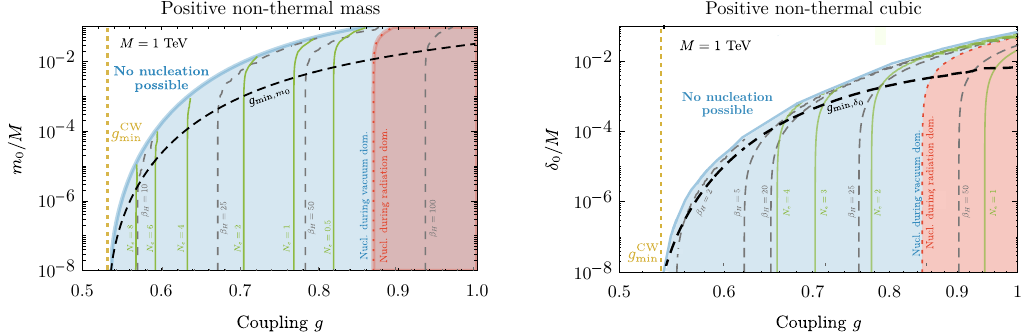
Figure 6 . Shrinking the supercooling window as a result of explicit conformal symmetry breaking with a positive mass-squared (left) and a positive cubic (right) , for a fixed scale of M = 1 TeV . Light blue shaded regions indicate a supercooled PT, while the light red regions indicate nucleation during radiation domination. The white region does not exhibit bubble nucleation, while the transparent blue line indicates the boundary of the supercooling window. Lastly, we show both the numeri- cally determined values of both β H ( grey dashed contours) and the number of e-folds of vacuum domination ( light green contours). The gold dashed vertical line denotes the lower boundary of the supercooling window for the scale-invariant model. The balc dashed line in both plots indicate our analytical approximation in eq.